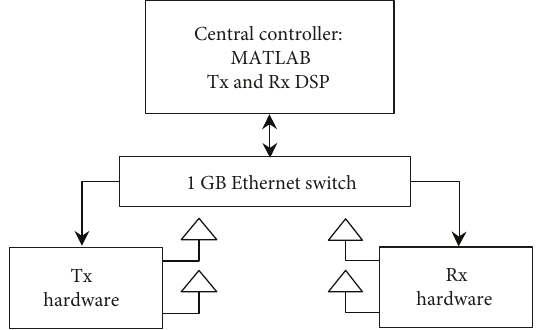
Figure 3: Block diagram of test-bed setup for a 2 × 2 MIMO